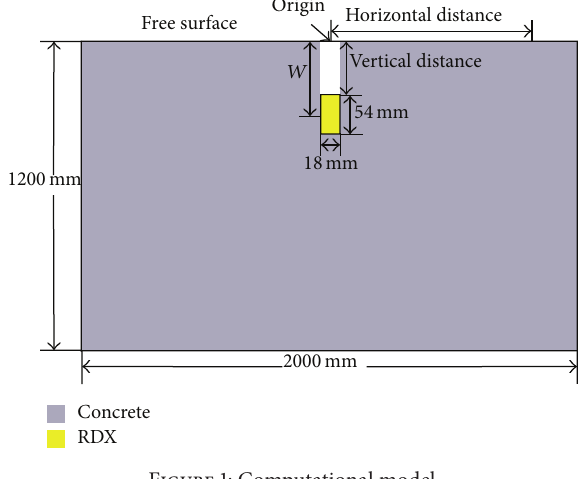
Figure 1: Computational